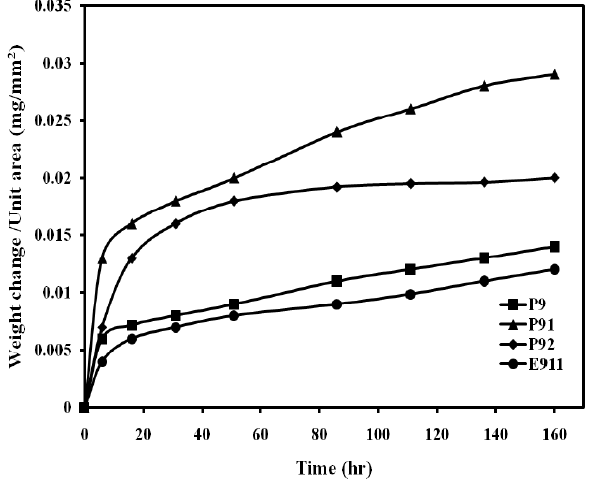
Figure 7. Weight change vs. time plots for alloys oxidized at 873 K in O 2 C 50 % H 2 O.